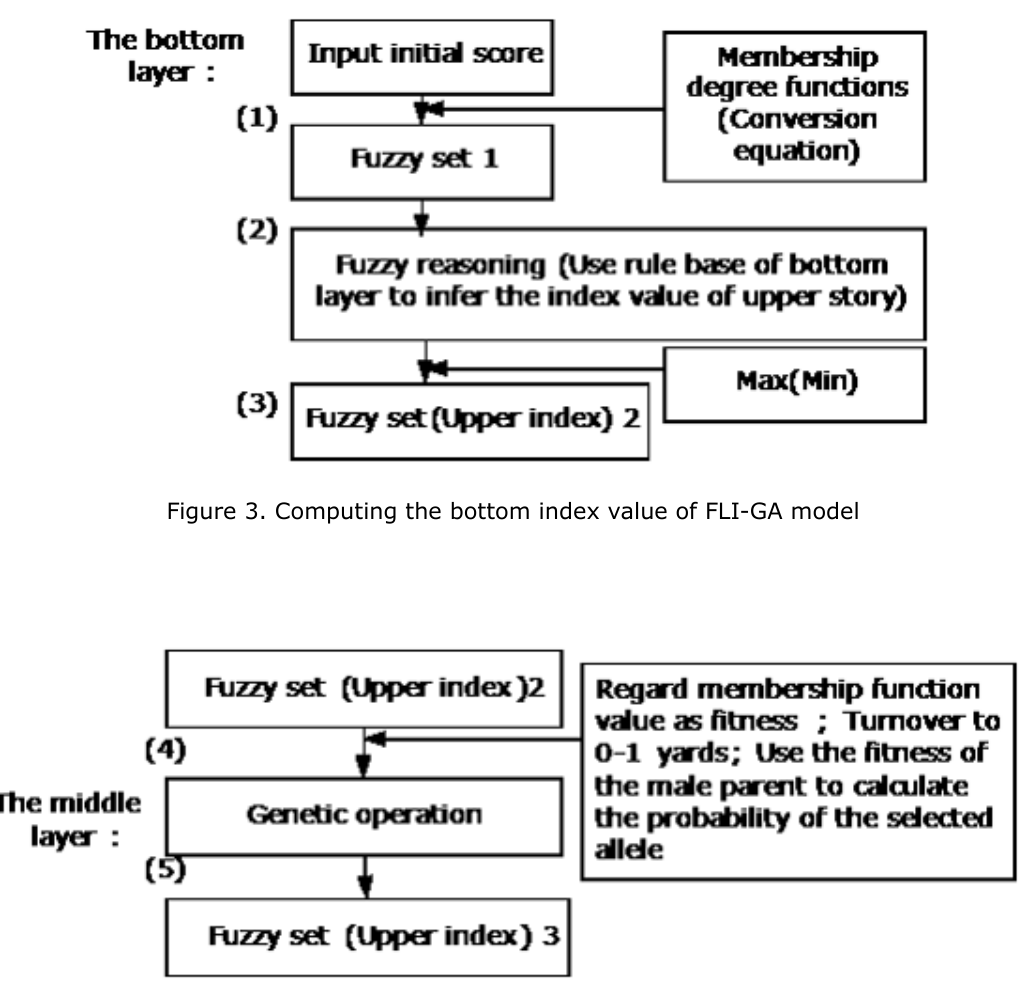
Figure 4. Computing the middle index value of FLI-GA model